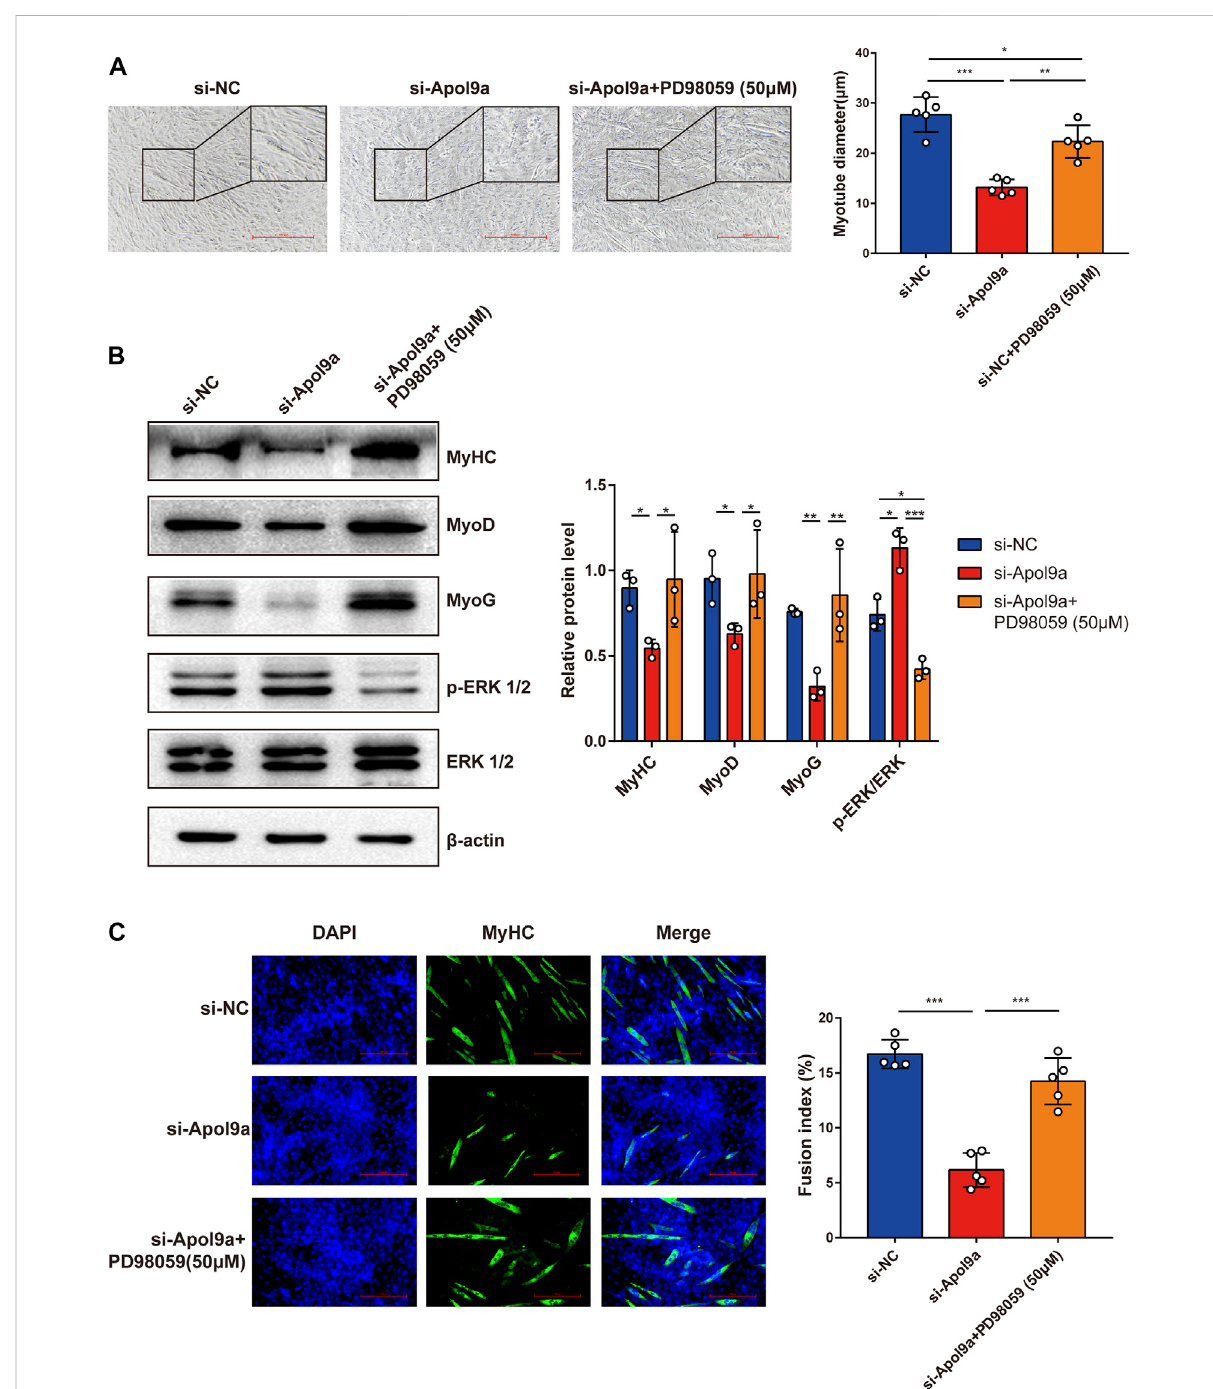
FIGURE 7 ERKinhibitorreverses Apol9a knockdown-inducedinhibitionofmyogenesis.C2C12cellsweretransfectedwithNCor Apol9a siRNA.After12 h, theGMwasreplacedwiththeDMtoinducedifferentiationorDMcontainingPD98059(50 μ m). (A) MorphologyofC2C12cellstreatedwithsi-NC,si- Apol9a , and si- Apol9a plus PD98059 (50 μ m). The results of quanti fi cation of average myotube diameter are shown in the right. (B) Protein expression levels of MyHC, MyoD, MyoG, p-ERK1/2, and ERK1/2 as detected through western blot analysis. Gray intensity analysis is shown on the right. (C) Representative images of immuno fl uorescence for MyHC (green) are shown. The fusion index (%) was quanti fi ed and is shown on the right. Scale bar, 100 μ m. Each experiment in this study was repeated at least three independent times. * p < 0.05, ** p < 0.01, *** p <